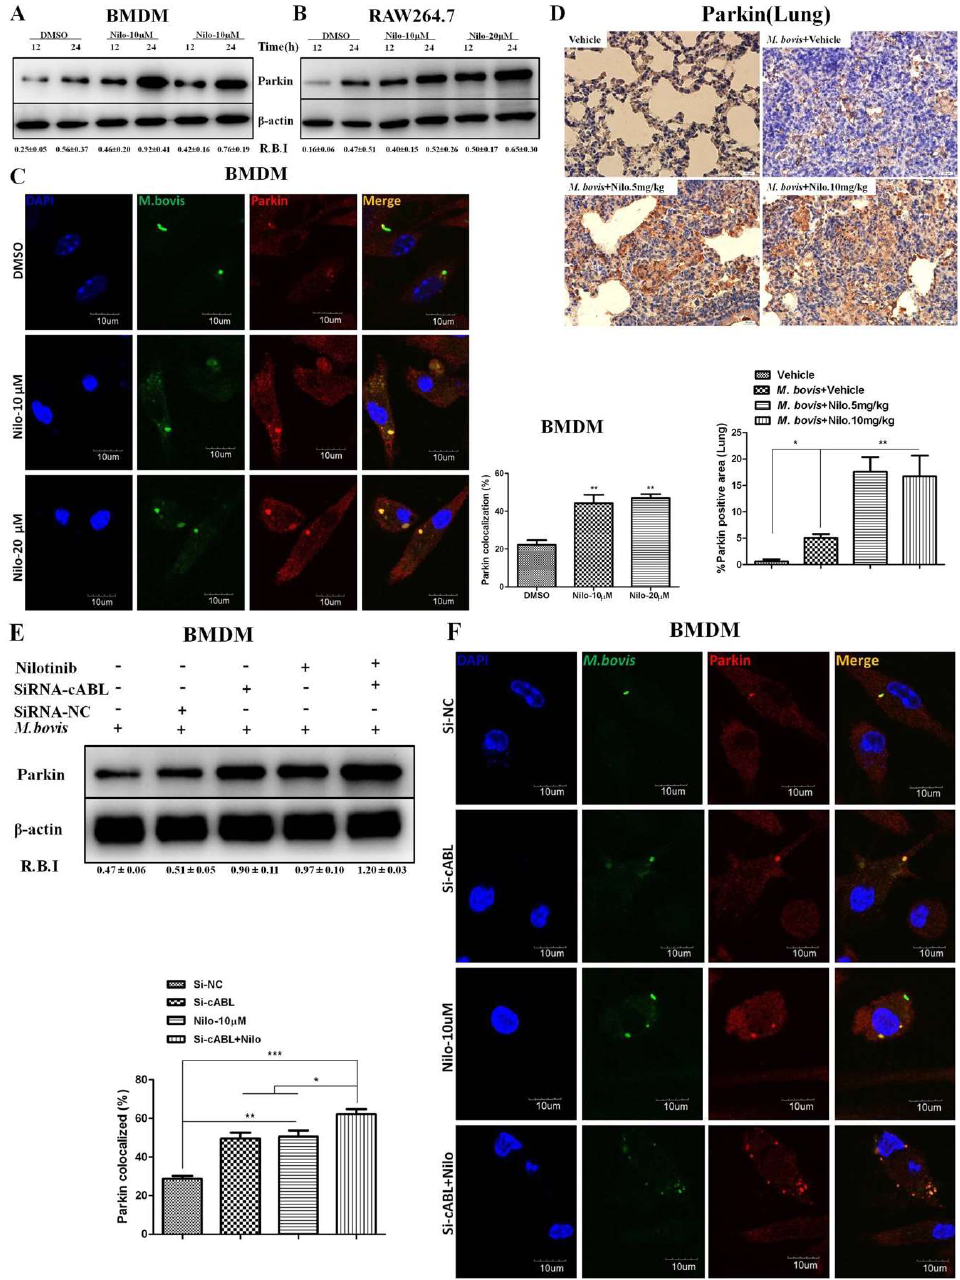
Figure 4. Nilotinib increases parkin activation during M. bovis infection. ( A , B ) BMDM and RAW264.7 cells were treated with DMSO (0.1%) or Nilotinib 10 µM and 20 µM followed by M. bovis (MOI 1:10) infection. Cells lysates were used for Parkin protein expression by WB. ( C ) BMDM cells were infected with M. bovis and treated with DMSO (0.1%) and Nilotinib 10 µM and 20 µM for 24 h.